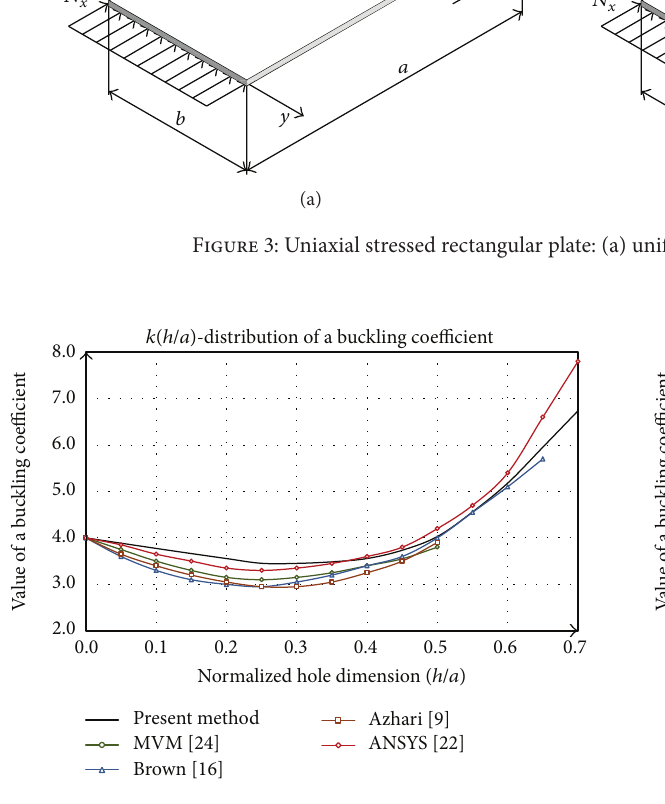
Figure 5: Comparative analysis of buckling coefficient of square plate with a square